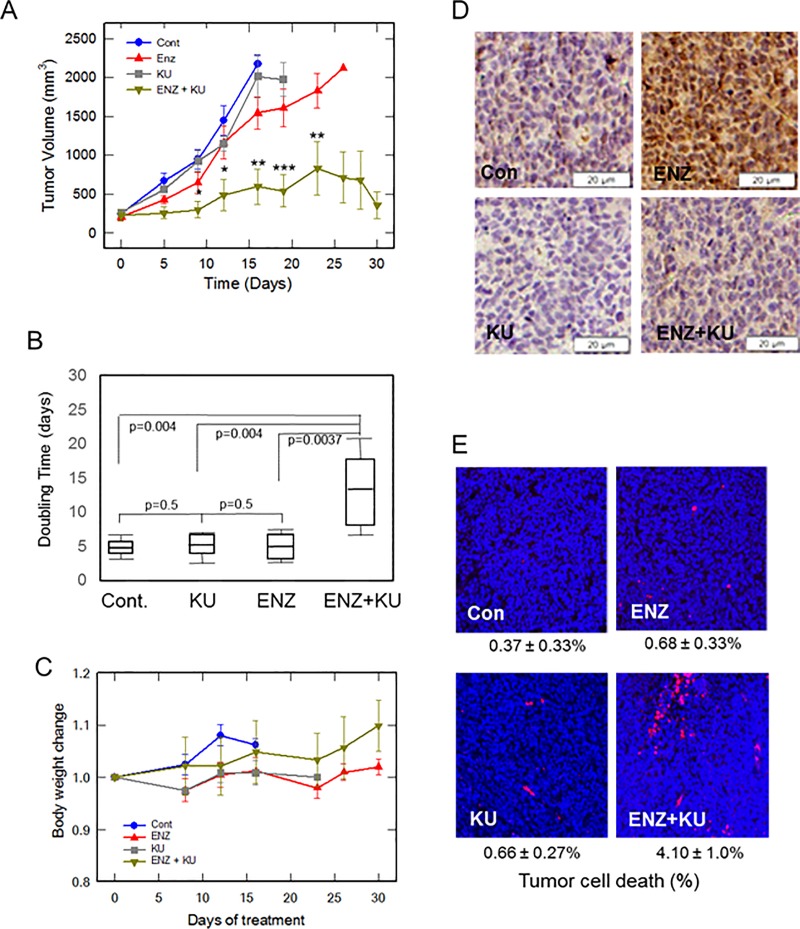
Combined treatment with AR antagonist ENZ plus ATMi inhibits growth of CRPC 22Rv1 xenograft tumors in mice that are resistant to each drug alone.22Rv1 tumor-bearing athymic nude mice were randomly assigned to vehicle control (Cont), ENZ, ATMi KU59403 (KU), or combined ENZ+KU treatment for 4 weeks. A) Tumor size over time is presented as mean tumor volume (mm3) of each treatment group (n = 6 or 7 mice/group). Error bars represent standard deviation. Statistical analysis was performed for comparison between ENZ alone or KU alone and KU+ENZ treatments: *, p<0.05; **, p<0.001; ***, p<0.0001. B) The doubling time of each tumor was calculated from a plot of log tumor volume vs. time. Doubling times of each treatment group are presented as Box-Whisker plots; horizontal lines represent mean, first and third quartiles, and whiskers represent the minimum and maximum doubling time of each group. The doubling time (days, mean ± SEM) of each group was: Control, 4.94 ± 1.0; KU, 5.50 ± 1.36; ENZ, 5.46 ± 1.36; ENZ+KU, 12.71 ± 4.38. P values are shown in the chart. C) Body weight of mice during the treatment period, relative to day 0 of treatment of each group. D) ENZ induces ATM activation in 22Rv1 xenograft tumors. Immunostaining of pATM is shown in a representative 22Rv1 xenograft tumor section from each treatment group. E) Evaluation of cell death in serial sections of 22Rv1 tumors. TUNEL assay to detect cell death was performed as described in the manufacturer’s protocol (InVitrogen). Images show ~1, 000 cells (blue) in a representative tumor tissue section from each treatment group. Cell death was analyzed by counting the percentage of cells that were dead (red) in each image.